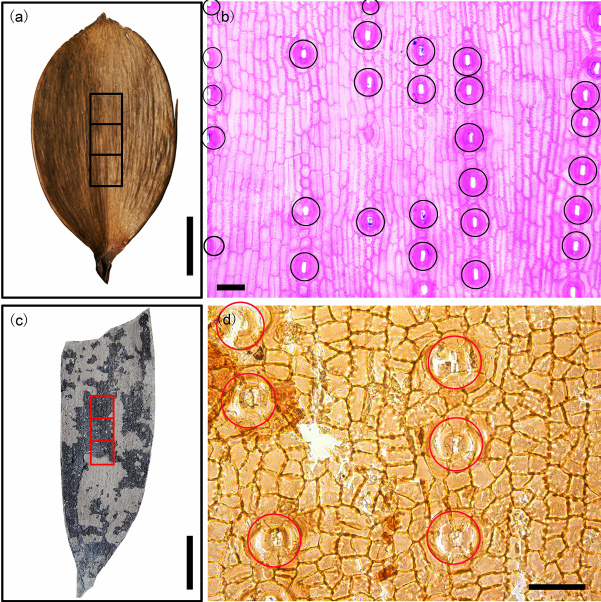
Figure 2. Sampling areas and counting rules are shown. (a) Nageia motleyi (Parl.) De Laub. leaf. Black squares in the middle of the leaf show the sampling areas for preparing the cuticles. (b) The abax- ial side of the cuticle from N. motleyi leaf. Black circles show the counted stomatal complexes. (c) N. maomingensis Jin et Liu. Red squares in the middle of the leaf indicate the sampling areas. (d) The abaxial side of the fossil cuticle. Red circles show the counted stom- atal complexes. Scale bars: (a) and (c) = 1cm; (b) and (d) = 50µm.